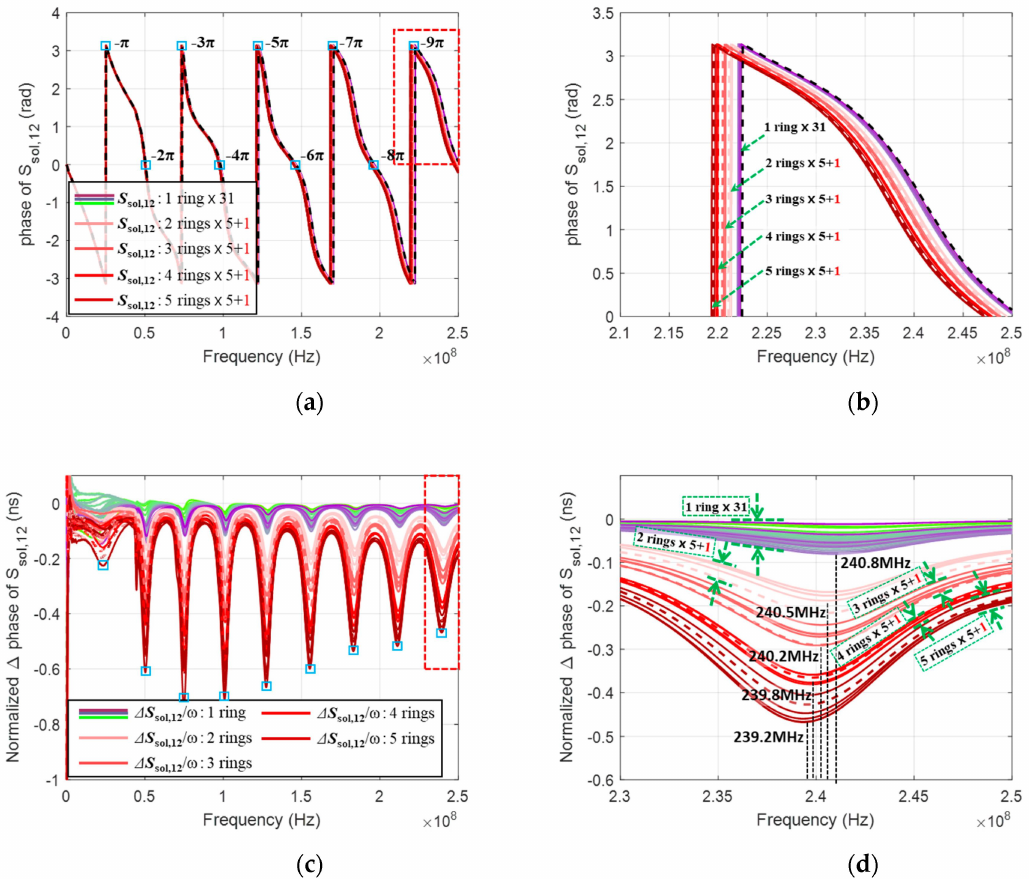
Figure 9. ( a ) Phase of S sol ,12 with 1500 Ω reference impedance which has been wrapped between − π and π ; ( b ) An enlargement of the red-dotted box in (a); ( c ) Normalized phase di ff erence with respect to angular frequency using Equation (15); ( d ) An enlargement of the red-dotted box in